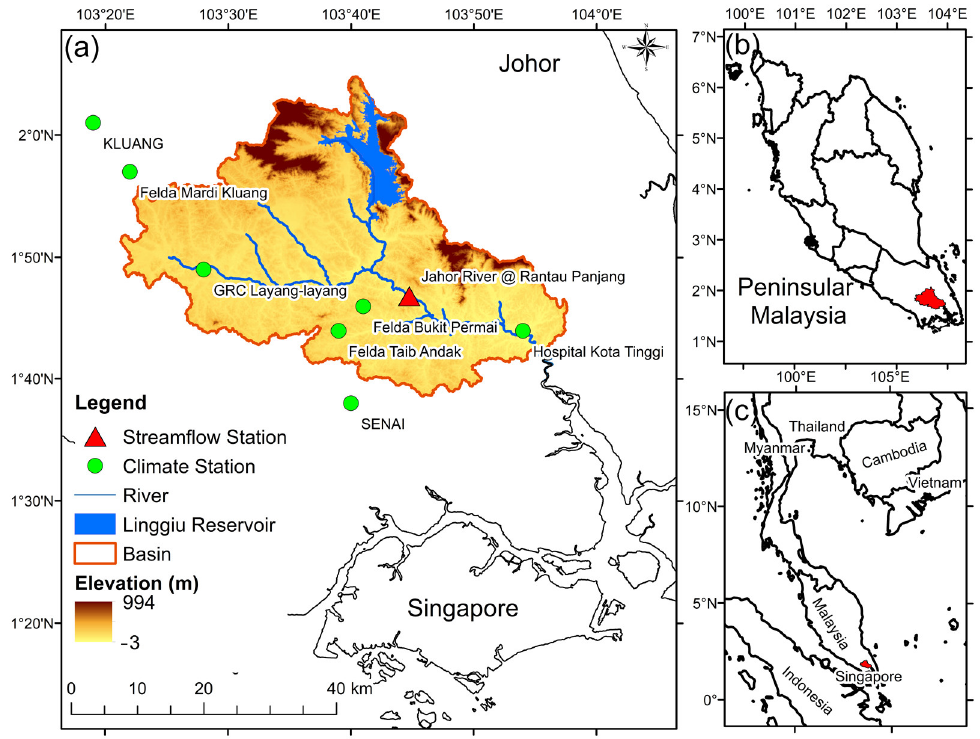
Figure 1. The location of ( a ) the Johor River Basin, ( b ) Peninsular Malaysia and ( c ) part of Southeast Asia.